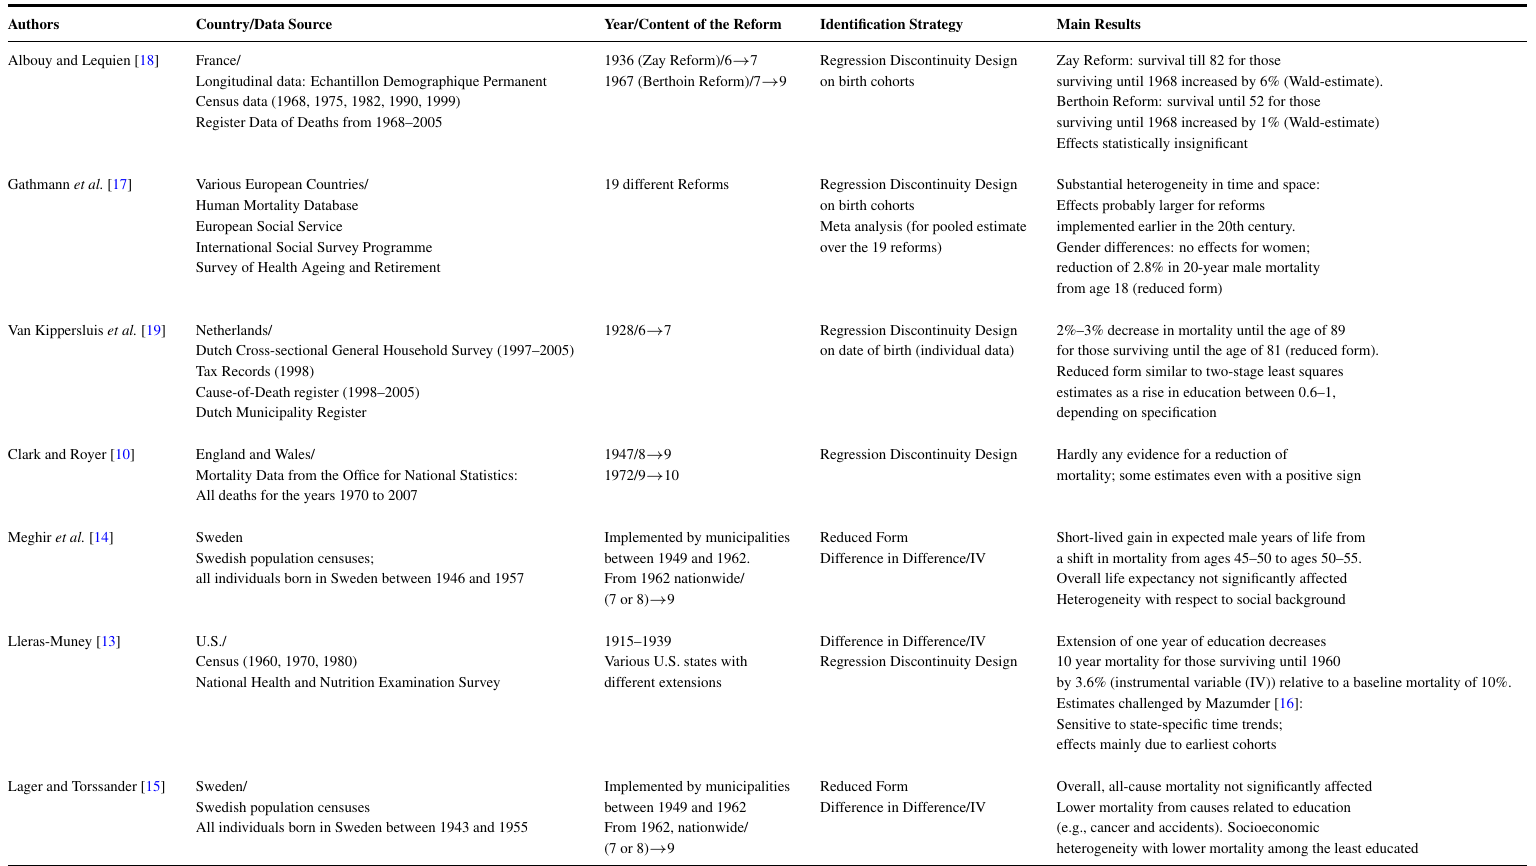
Table 1. Literature overview: causal effects of compulsory schooling on